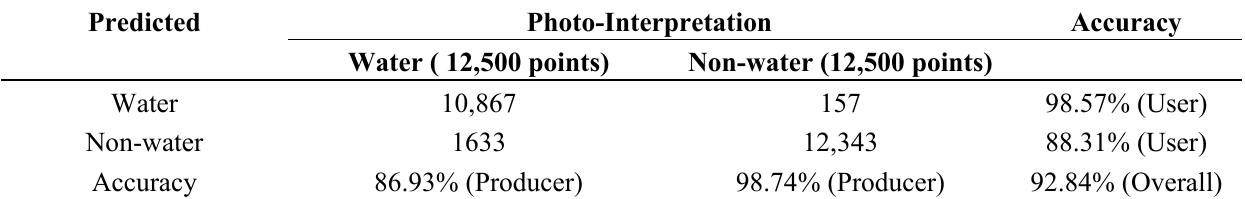
Table 2. Confusion matrix of the global water map produced in this